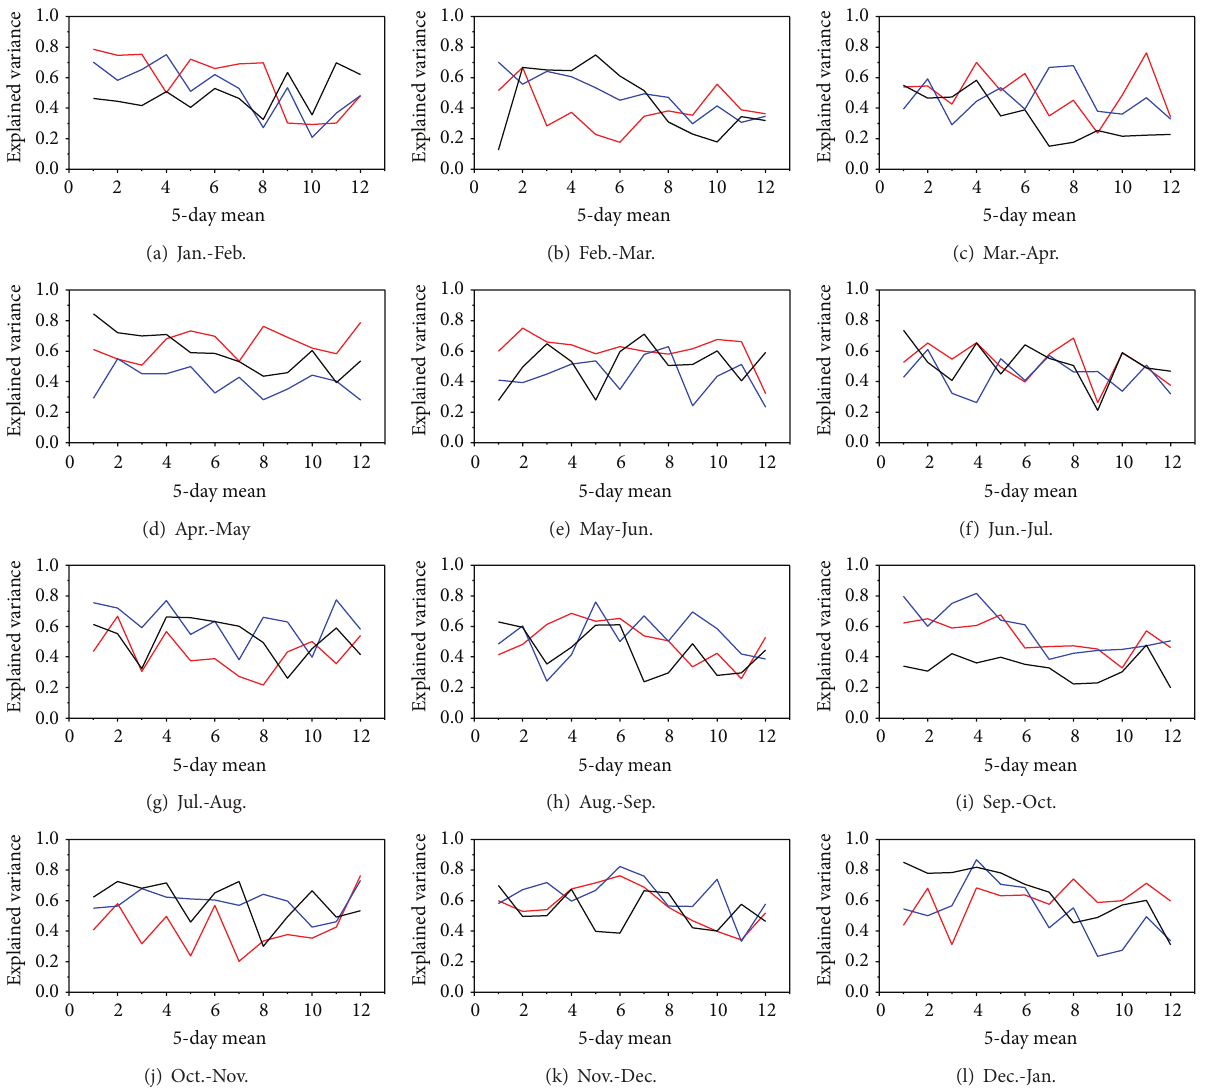
Figure 1: Monthly change in the pentad average of the explained variance for 10–30-day STs of the Northern Hemisphere 500 hPa height field. The blue line denotes the La Ni˜na year, the red line denotes the El Ni˜no year, and the black line denotes the neutral